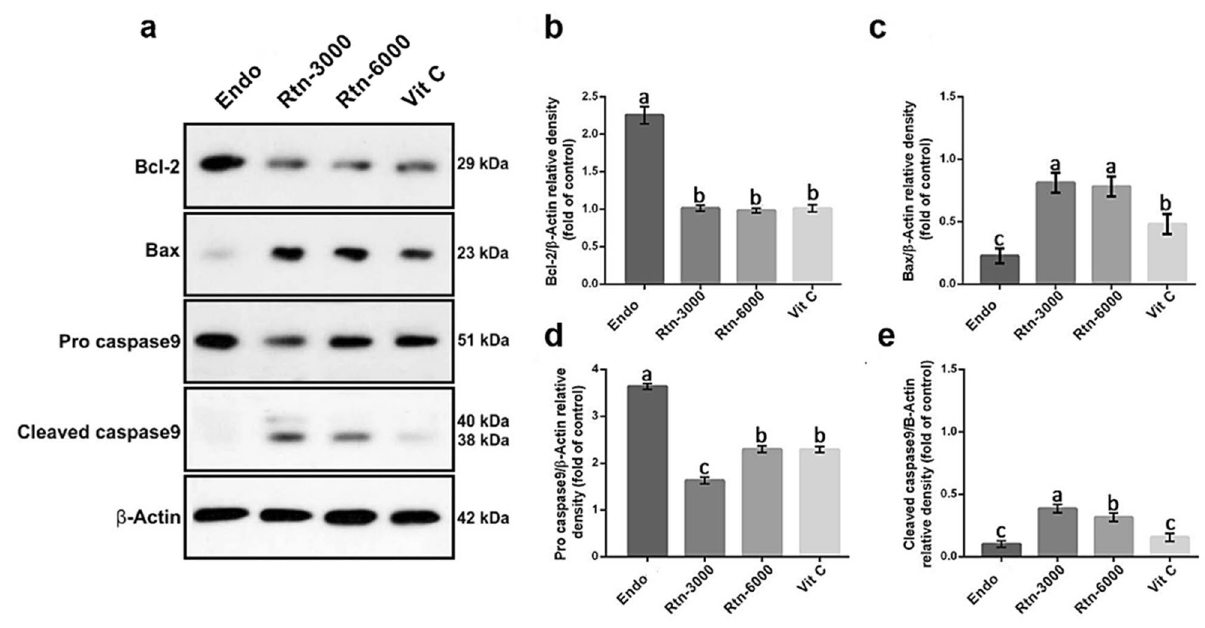
Figure 1. ( a ) Determination of Bcl-2, Bax, Pro caspase9, Cleaved caspase9 and β-actin by Western blot in cell lysates. Western blotting of Bcl-2, Bax, Pro caspase9, and Cleaved caspase9 were performed on lysates of the various cell lines by specific antibodies. β actin was used as an internal control. ( b ), ( c ), ( d ) and ( e ), Quantitative analyses of Bcl-2, Bax, Pro caspase9, and Cleaved caspase9 were performed in the various cell lines by Western blot analysis. The mean optical density ratio for Bcl-2, Bax, Pro caspase9, and Cleaved caspase9 was calculated in per endometriotic cell type and compared to control endometrial cells. Superscripts (a, b, c) show significant differences between groups at P <